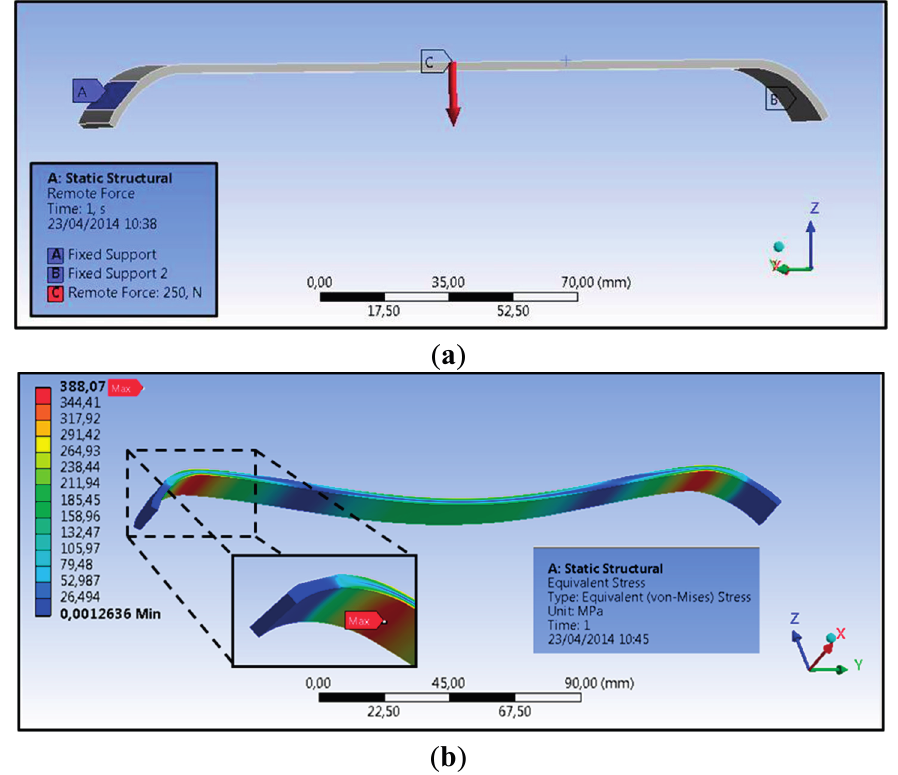
Figure 4. ( a ) CAD representation of Nuss bar with an applied force of 250 N (red arrow—C) and the two “fixed support” constraints (blue areas—A, B); ( b ) Stress distribution on the bar. The area subjected to the maximum stress is shown in the inset. Nuss bar D long configuration is represented in the figure as an example of the 14 simulations.